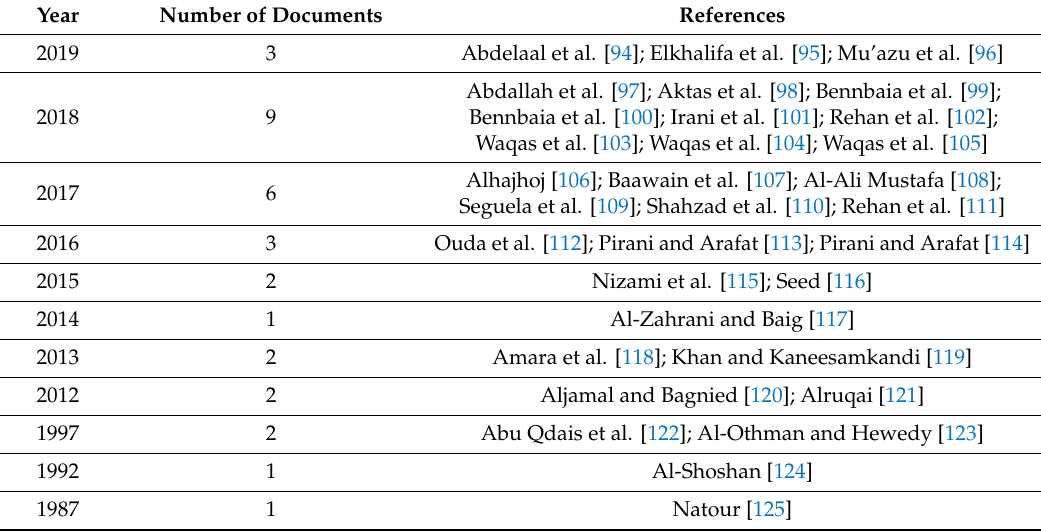
Table 1. Documents considered in the systematic review of literature on food waste in the Gulf Cooperation Council (GCC)